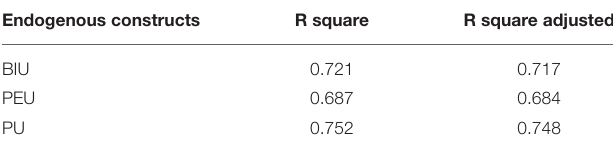
TABLE 9 | Results of R 2 values.